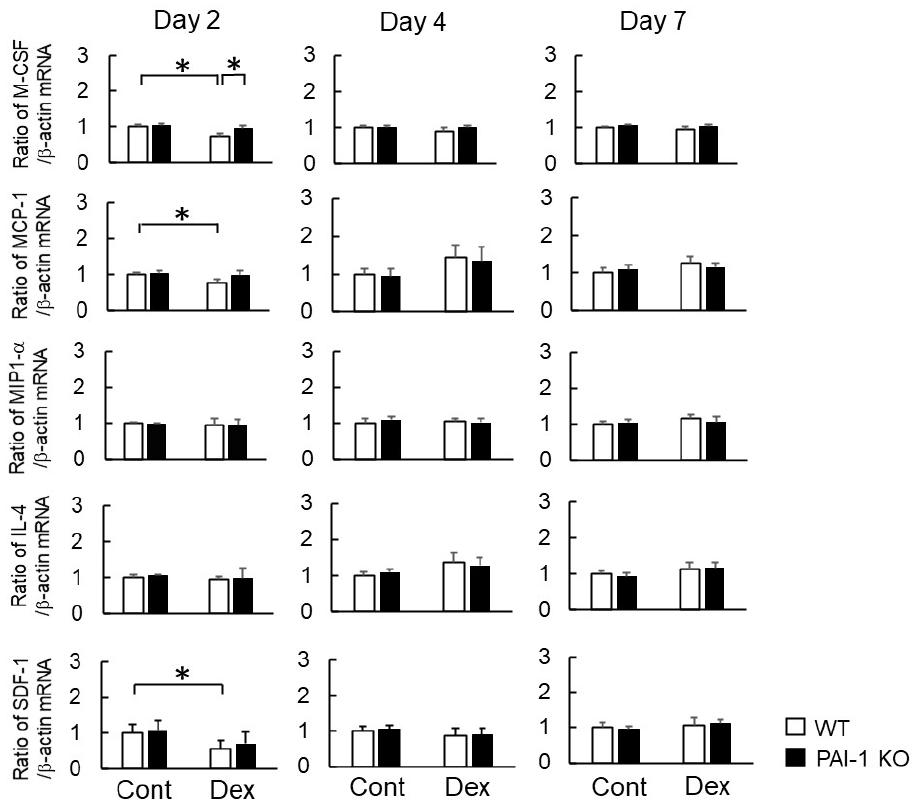
Figure 3. Effects of Dex and PAI-1 deficiency on the expression of macrophage-related factors at the damaged site after femoral bone injury. A real-time PCR analysis of M-CSF , MCP-1 , MIP-1 α , IL-4 , SDF-1 , and β -actin mRNA at damaged sites 2, 4, and 7 days after femoral bone injury in WT and PAI-1 KO mice. Data are expressed relative to β -actin mRNA values. Data represent the mean ± SEM: n = 5. * p < 0.05.